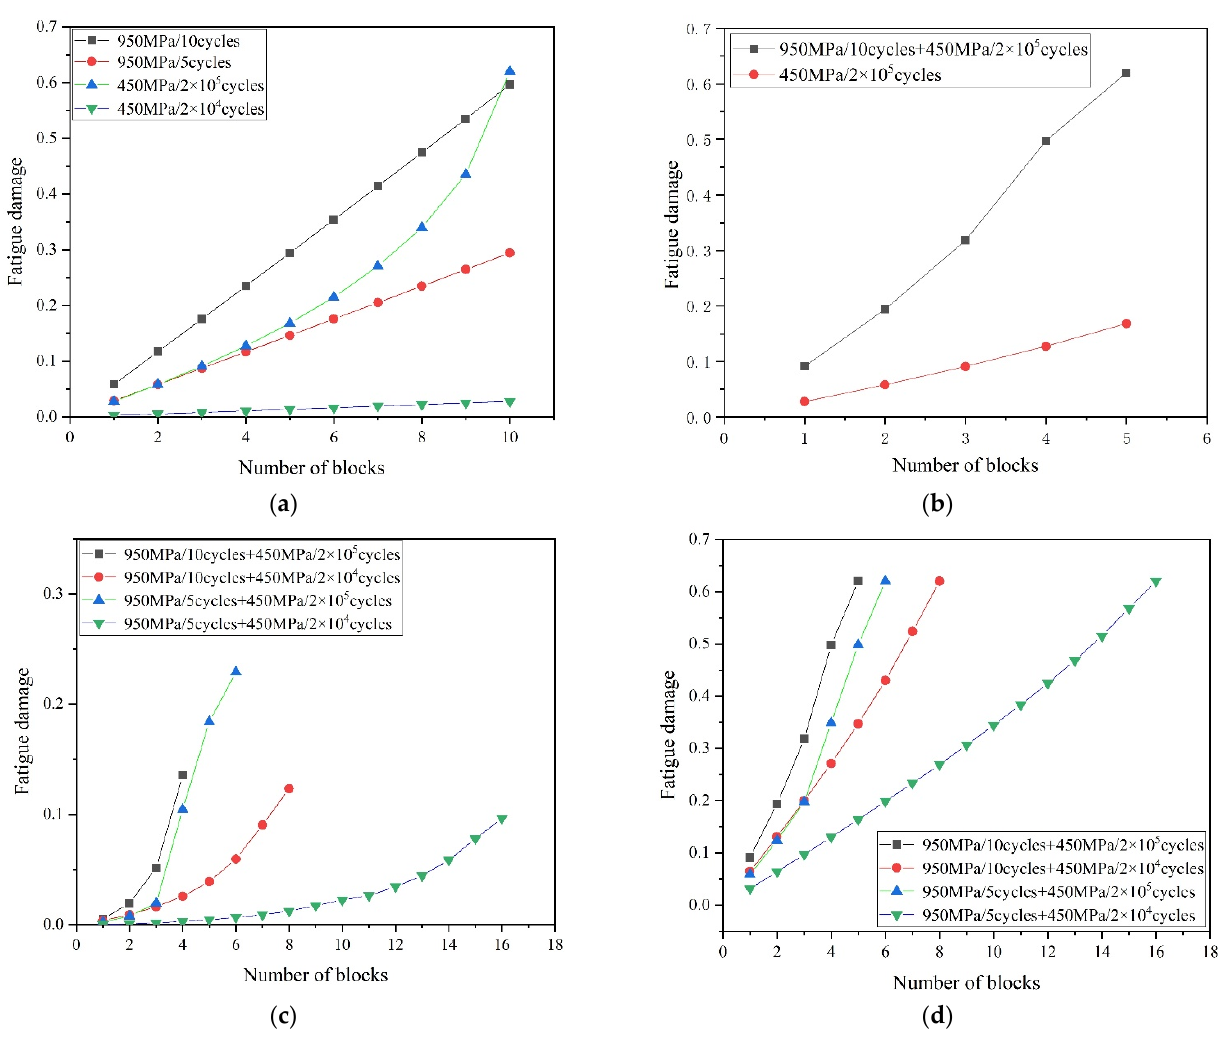
Figure 9. ( a ) Fatigue damage under constant amplitude loading; ( b ) comparison of stress blocks and low stress fatigue damage; ( c ) the interaction fatigue damage in different stress block; and ( d ) the total cumulative fatigue damage.